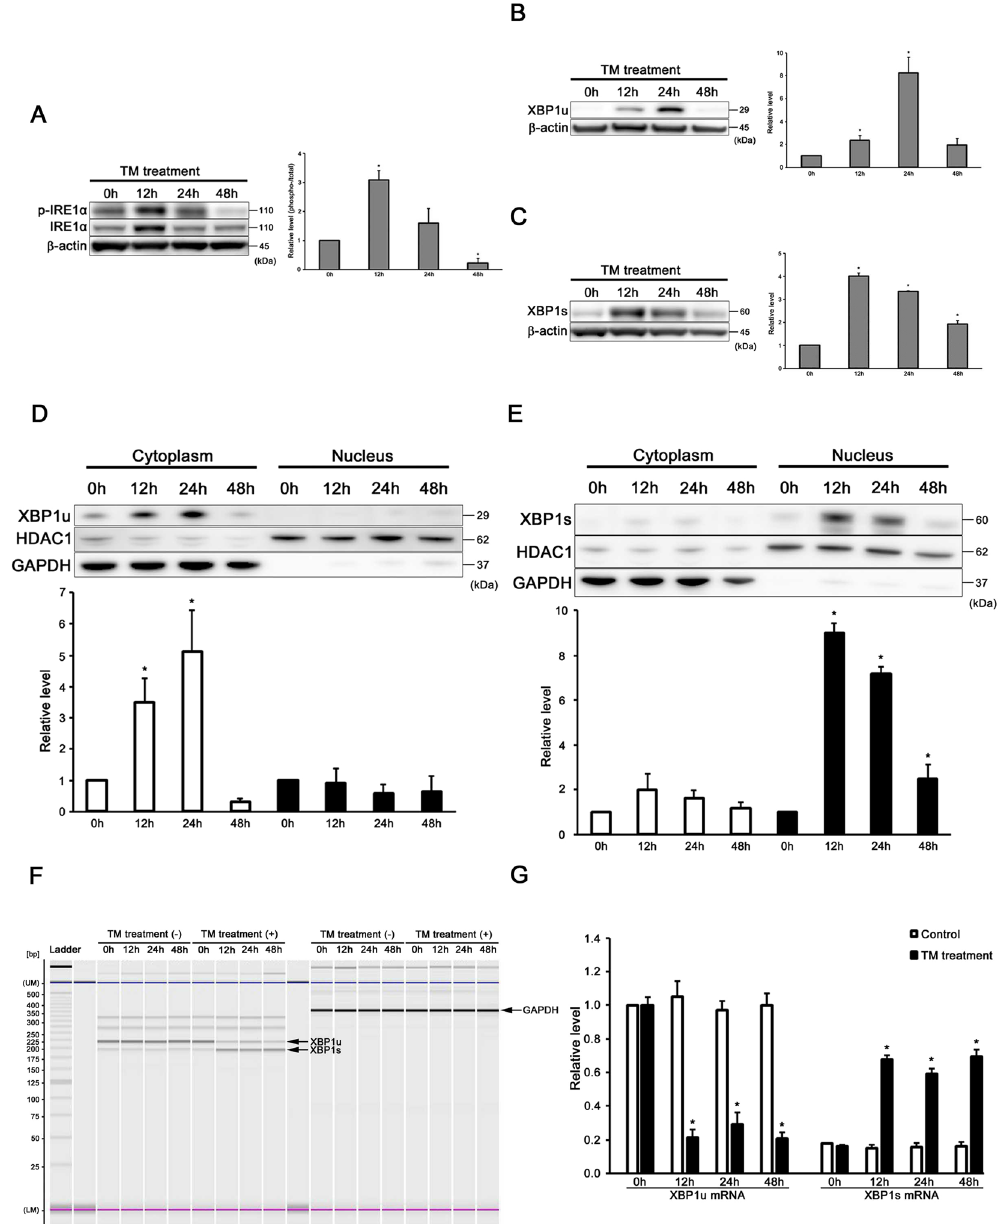
Figure 2. ER stress induces XBP1 mRNA splicing in auditory cells. ( A – C ) Representative Western blots showing the expressions of ( A ) p-IRE1 α , IRE1 α , ( B ) XBP1u and ( C ) XBP1s. β -actin was included as a loading control. The expressions of p-IRE1 α , IRE1 α , XBP1u and XBP1s were detected, and the means ± S.D. (fold of changes over the control group) of three or more independent studies were presented ( * p < 0.05 versus control group). Full-length blots are presented in Supplementary Figure 2a–f. ( D , E ) Western blots showing cytoplasmic and intranuclear XBP1u and XBP1s expressions at the designated time after tunicamycin treatment (50 µ g/ ml for 48 h). GAPDH was included as a loading cytoplasm control, and HDAC1 was used as a nuclear control. The expression of XBP1u was detected only in the cytoplasm. The expression of XBP1s was detected only in the nucleus. The means ± S.D. (fold of changes over the control group) of three or more independent studies were presented ( * p < 0.05 versus control group). Full-length blots are presented in Supplementary Figure 2g–l. ( F , G ) RT-PCR analysis showing the expression of XBP1u mRNA and XBP1s mRNA. Cells were treated with or without 50 µ g/ml tunicamycin for designed periods (12, 24 and 48 h), and the total RNA was extracted and subjected to RT-PCR analysis. GAPDH was included as a loading control. “UM” and “LM” each indicate the upper and lower markers, respectively. The expressions of XBP1u mRNA and XBP1s mRNA were detected, and the means ± S.D. (fold of changes over the control group) of three independent studies were presented ( * p < 0.05 versus control